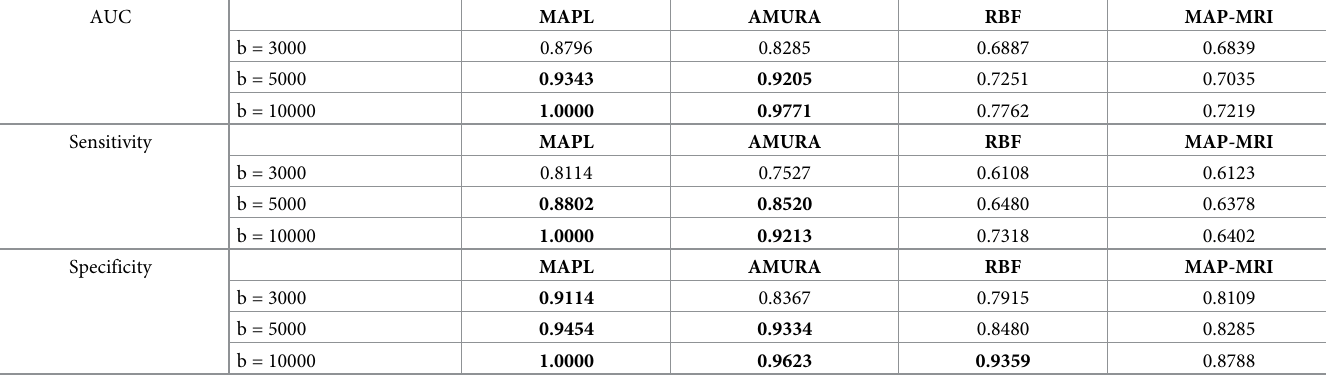
Table 4. ROC FoMs for RTOP (the closer to 1, the better). MAPL with 4 shells at a maximum b = 10,000s/mm 2 is the bronze standard. AUC